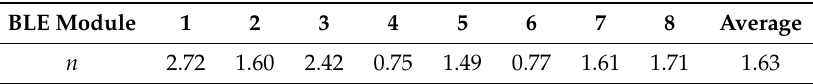
Table 5. Calculations of the loss path exponent n .